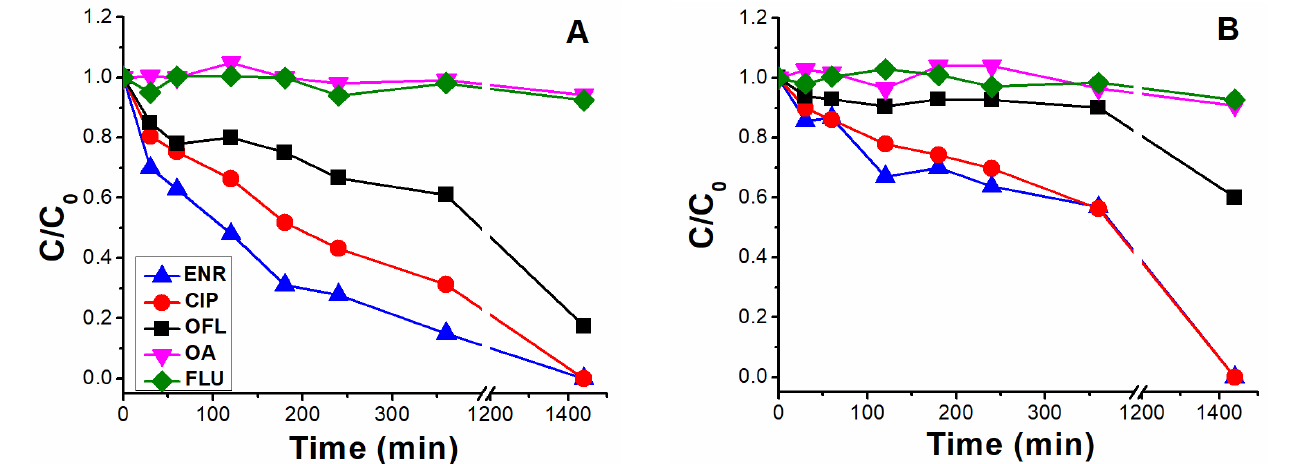
Figure 6. Photolysis of solutions containing the five (fluoro)quinolones ((F)Qs) mixed, each one with an initial concentration of 0.25 µM, into ( A ) ultra-pure water and ( B ) seawater.